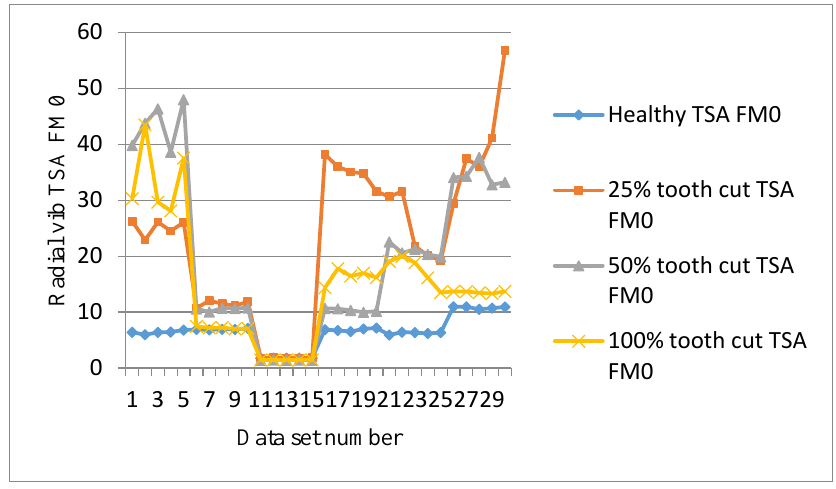
Figure 17. FM0 of radial vibration TSA signals.